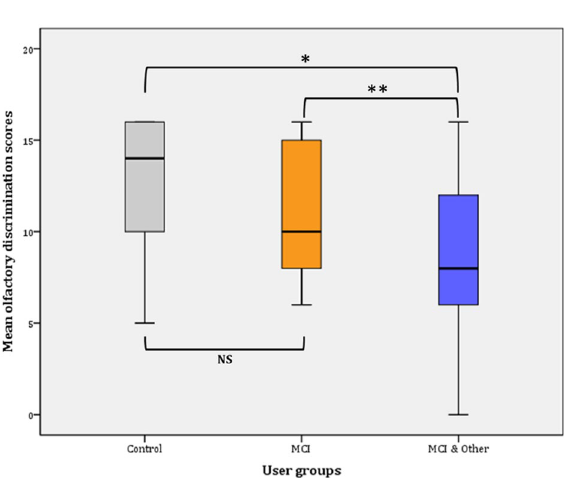
Figure 3. Mean olfactory discrimination scores (Phase